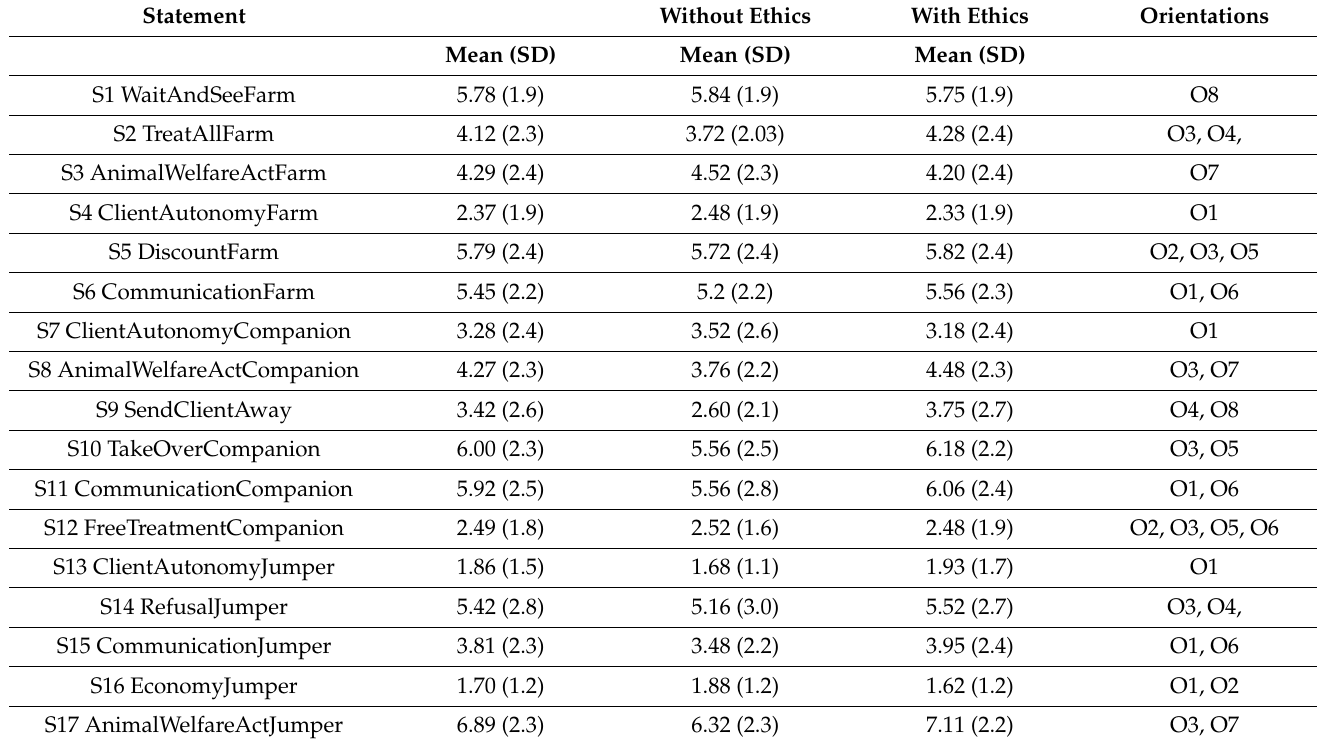
Table 2. Descriptive statistics of the 17 statements.